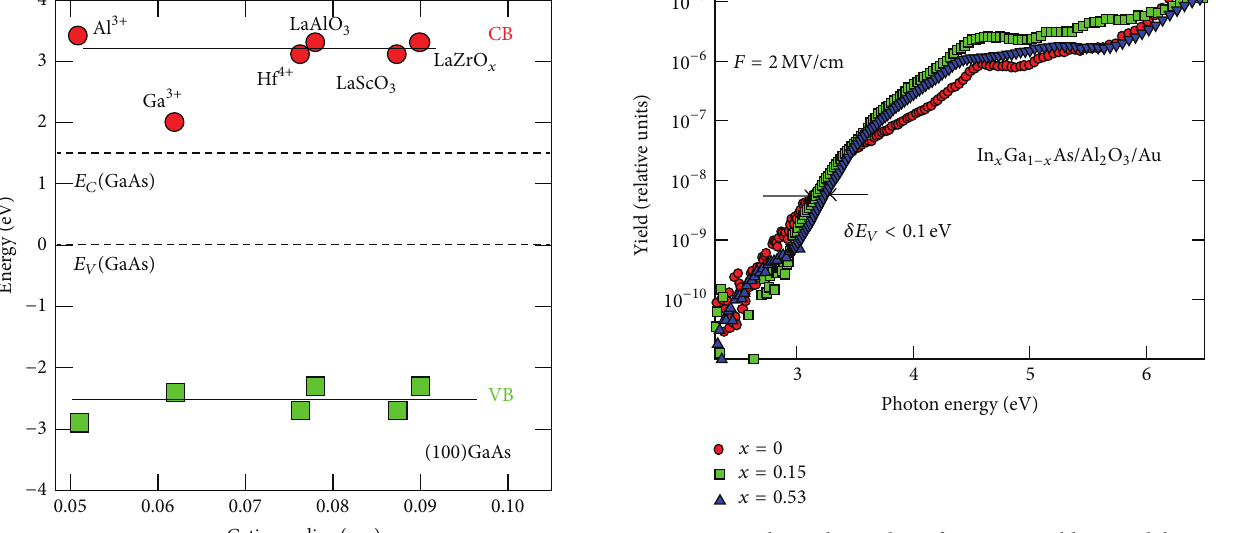
Figure 26: Semilogarithmic plots of quantum yield spectral depen- dences in samples with Al 2 O 3 insulator on In 𝑥 Ga 1−𝑥 As epitaxial layers for different concentrations of In in the semiconductor. The curves are measured under positive bias on the top metal electrode corresponding to the average strength of electric field in the oxide of 2